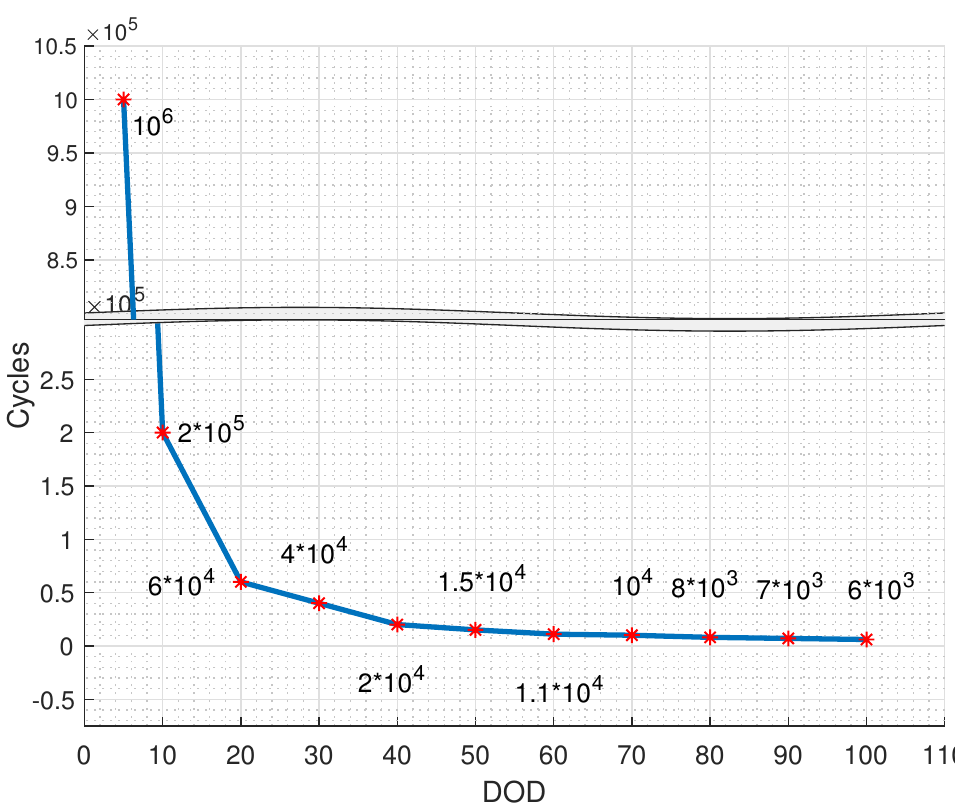
Figure 2. Relationship between DOD and useful life